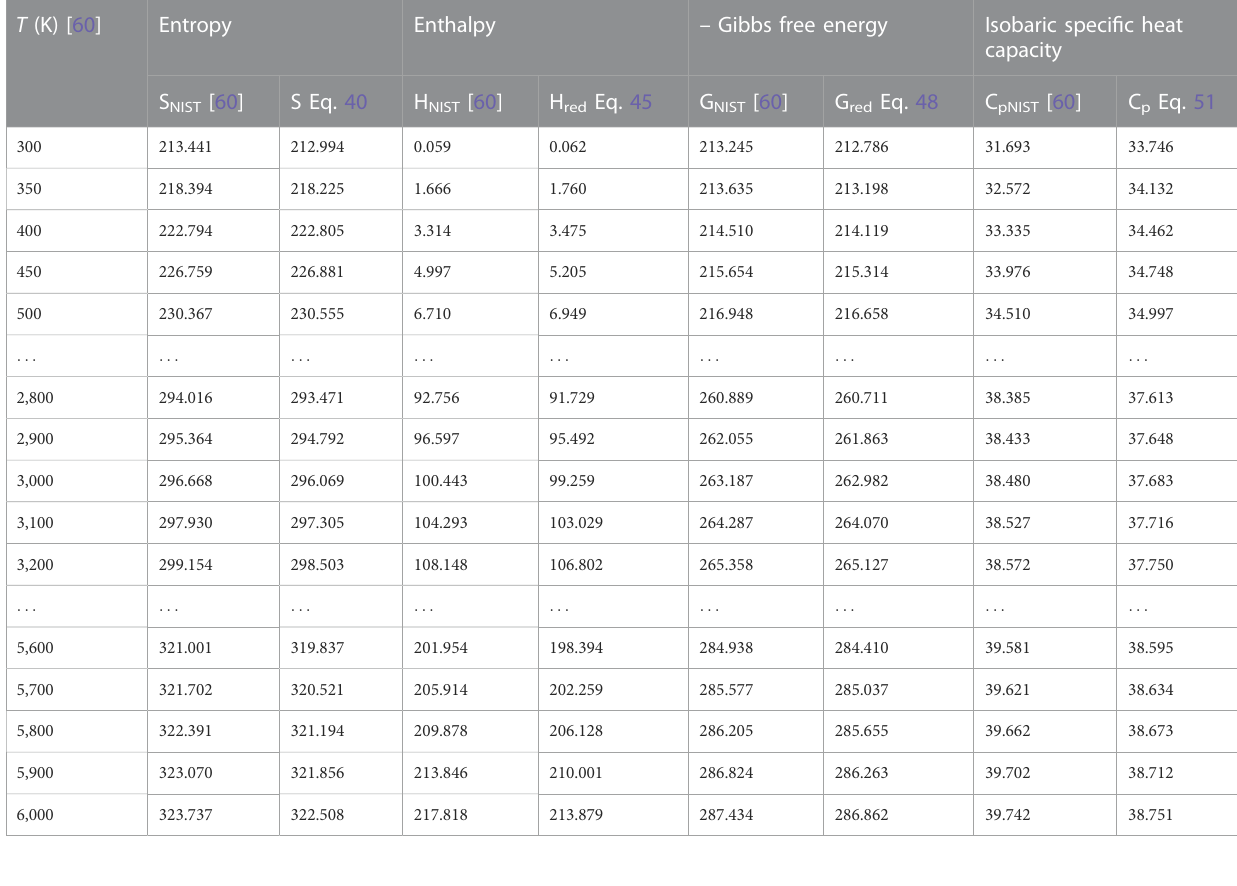
TABLE 4 Computed data on molar entropy (J mol − 1 K − 1 ), reduced enthalpy (kJ mol − 1 ), reduced Gibbs free energy, and isobaric speci fi c heat capacity for the BCl (X 1 Σ + ) molecule. N p =